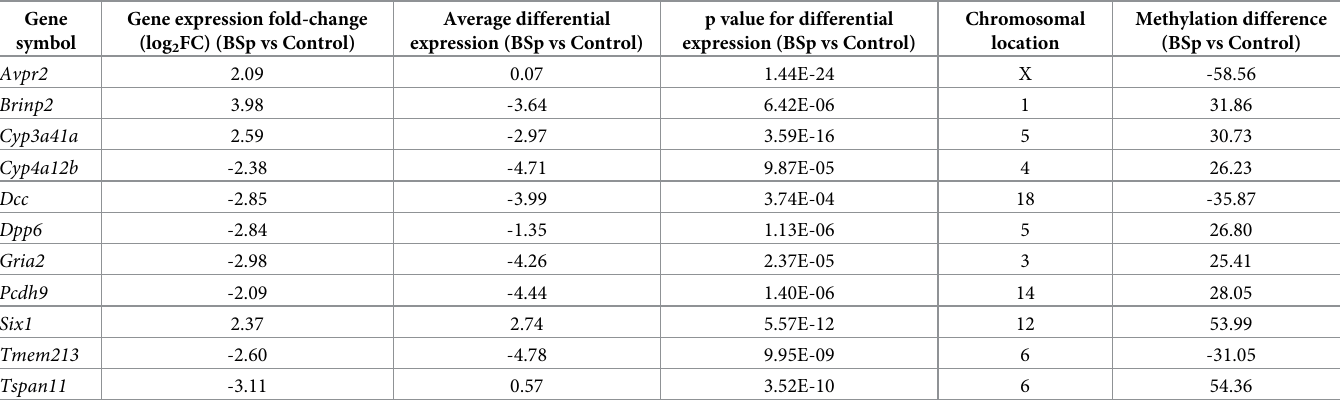
Table 3. Identified target genes with significant DE and DM changes due to maternal dietary administration of BSp in the offspring of SV40 transgenic mice. Gene Gene expression fold-change symbol (log 2 FC) (BSp vs Control)